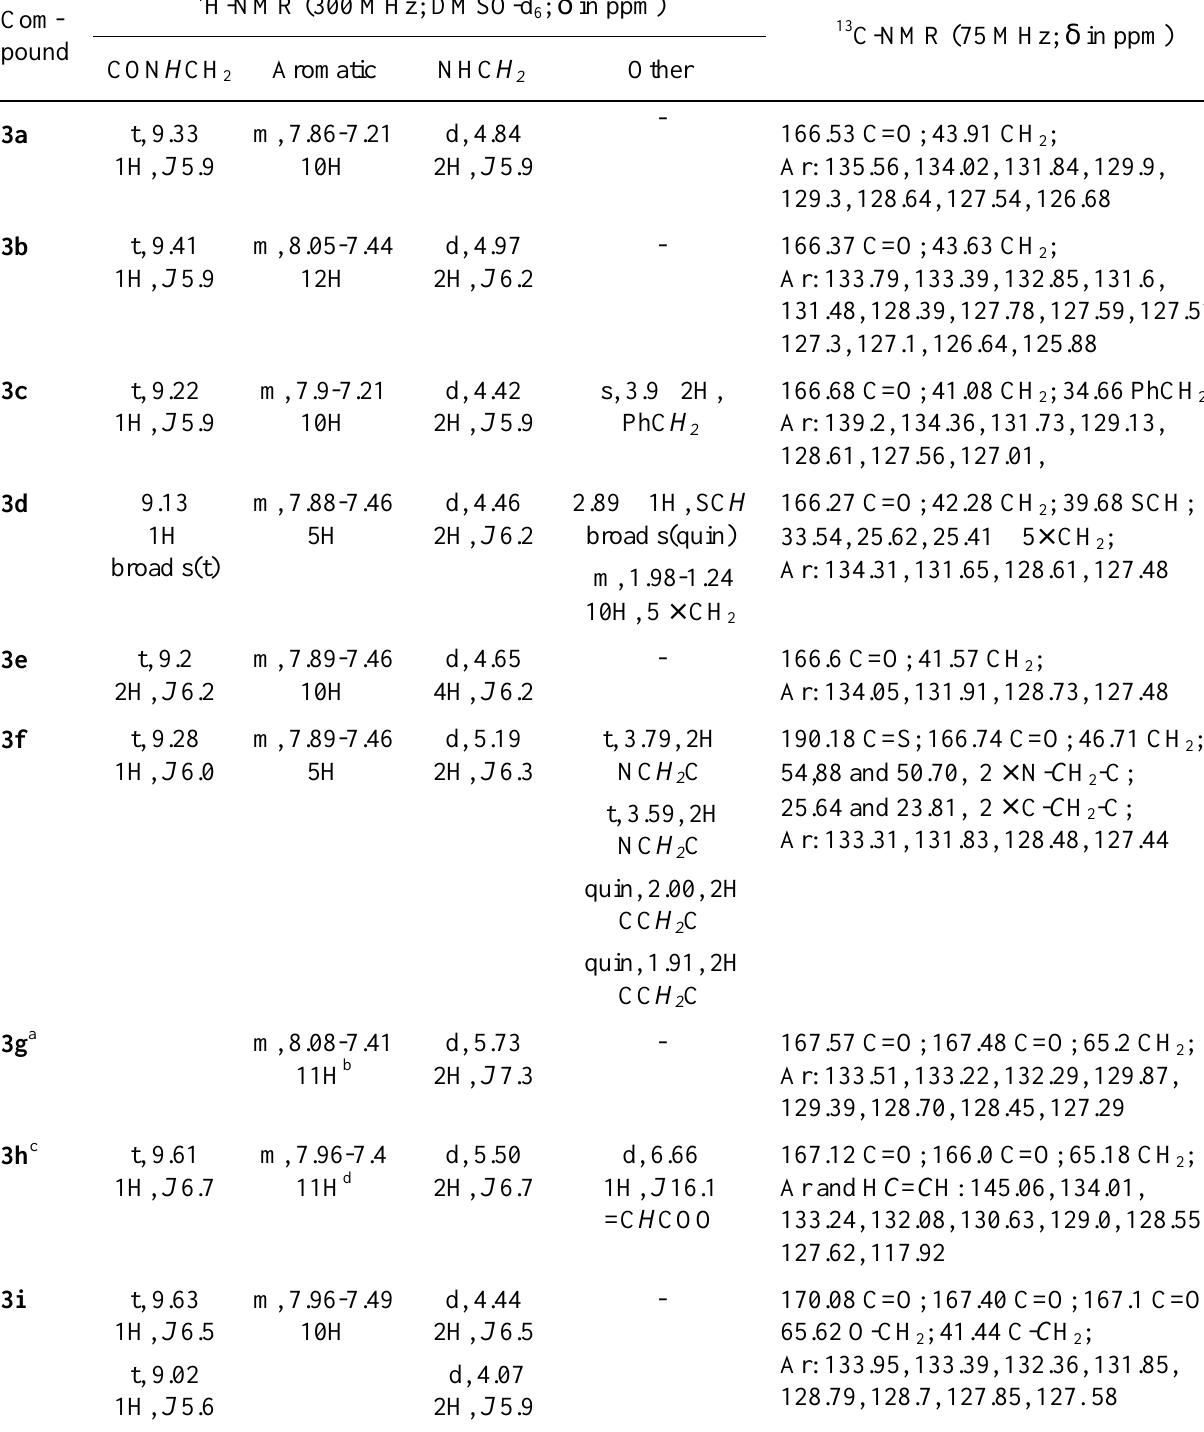
Table 1. NMR data of compounds 3a - i